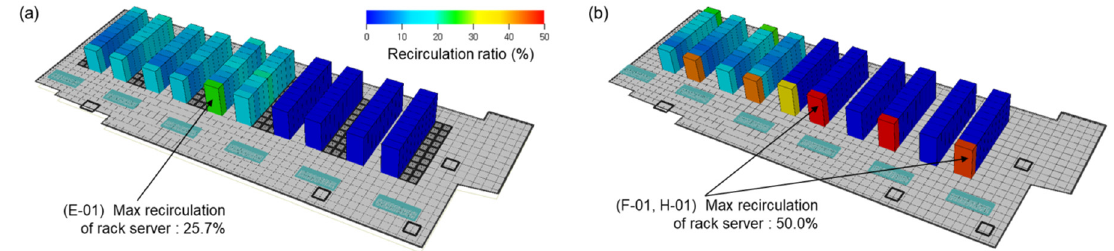
Figure 11. The recirculation ratio of 100 server racks in normal cooling condition; ( a ) ALT-1: HAC raised floor and ( b ) ALT-2: HAC hard floor.